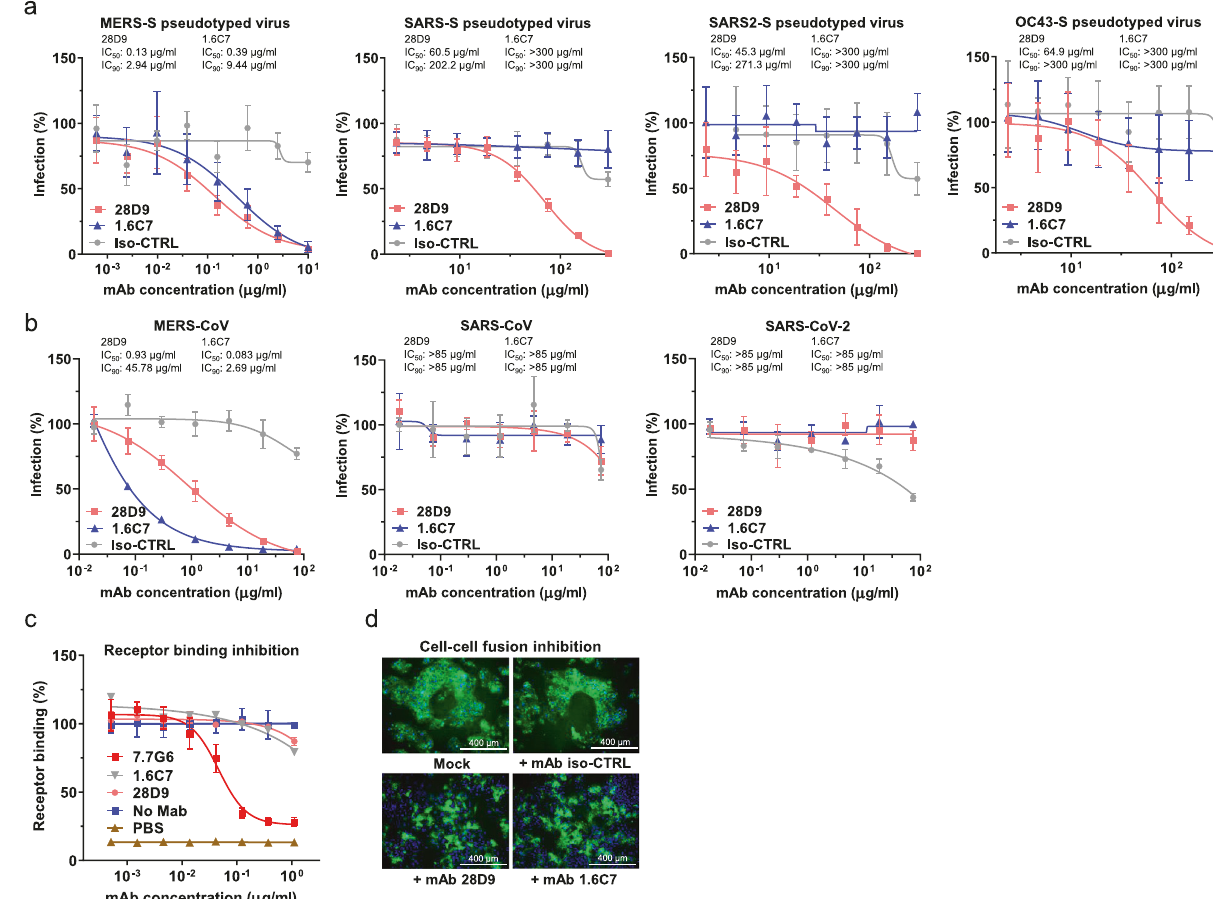
Fig. 2 Cross-neutralization capacity of mAbs 28D9 and 1.6C7 and mechanism of action. a Antibody-mediated neutralization of infection of luciferase- encoding VSV particles pseudotyped with spike proteins of MERS-CoV, SARS-CoV, SARS-CoV-2 and HCoV-OC43. Pseudotyped VSV particles pre- incubated with antibodies at indicated concentrations were used to infect VeroCCL81 cells (MERS-S pseudotyped VSV), VeroE6 cells (SARS-S and SARS2- S pseudotyped VSV) or HRT-18 cells (OC43-S pseudotyped VSV) and luciferase activities in cell lysates were determined at 20 h post transduction to calculate infection (%) relative to non-antibody-treated controls. The average ± SD ( n ≥ 6) from at least two independent experiments performed is shown. Iso-CTRL: an anti-Strep-tag human monoclonal antibody was used as an antibody isotype control. The IC 50 and IC 90 values were shown. Source data are provided as a Source Data fi le. b Antibody-mediated neutralization of MERS-CoV, SARS-CoV and SARS-CoV-2 infection. Neutralization of authentic viruses was performed using a plaque reduction neutralization test (PRNT) on VeroCCL81 cells (MERS-CoV) or VeroE6 (SARS-CoV and SARS-CoV-2) as described earlier 74,75 . The experiment was performed with triplicate samples, the average ± SD is shown. The IC 50 and IC 90 values were shown. Source data are provided as a Source Data fi le. c ELISA-based receptor-binding inhibition assay. MERS-S ecto pre-incubated with serially diluted mAbs was added to ELISA plates coated with soluble human DPP4. The binding of MERS-S ecto to DPP4 was detected using an HRP-conjugated antibody recognizing the C- terminal Strep-tag on MERS-S ecto . Data points represent the average ± SD, for n = 3 replicates from two independent experiments. Source data are provided as a Source Data fi le. d Cell-cell fusion inhibition assay. Huh-7 cells — transfected with plasmid expressing (GFP-tagged) MERS-CoV S were pre- incubated in the presence or absence of 1.6C7 and 28D9, or an irrelevant iso-type control antibody (Iso-CTRL), and then treated with trypsin to activate the membrane fusion function of the MERS-CoV S protein. The formation of MERS-S mediated syncytia was visualized by fl uorescence microscopy. Merged images of MERS-S-GFP expressing cells (green) and DAPI-stained cell nuclei (blue) are shown. The experiment was performed twice, data from a representative experiment is shown. Source data are provided as a Source Data fi